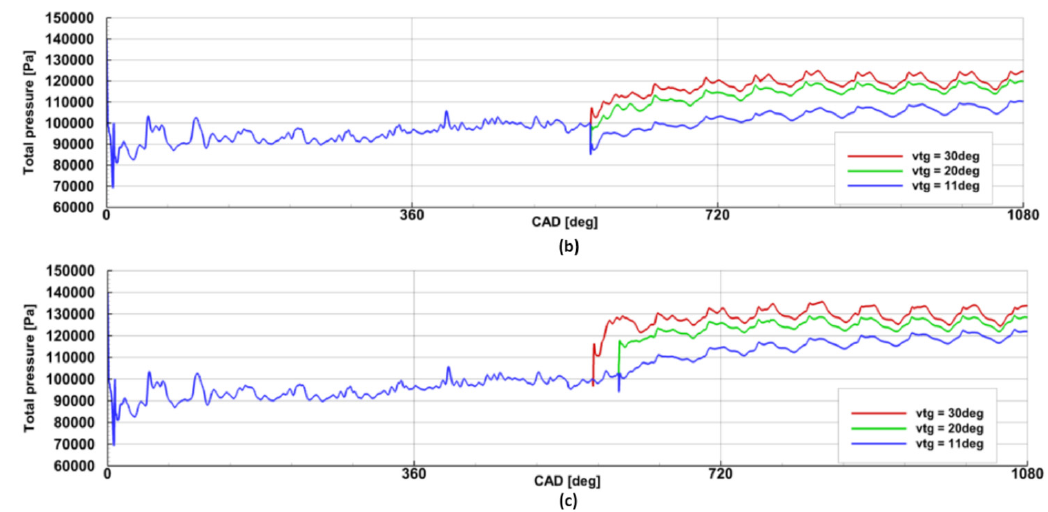
Figure 18. The outlet total pressure variation of the 2nd stage rotor at the three different VTG openings for: ( a ) 60,000 rpm, ( b ) 50,000 rpm, ( c ) 40,000 rpm turbine speed.